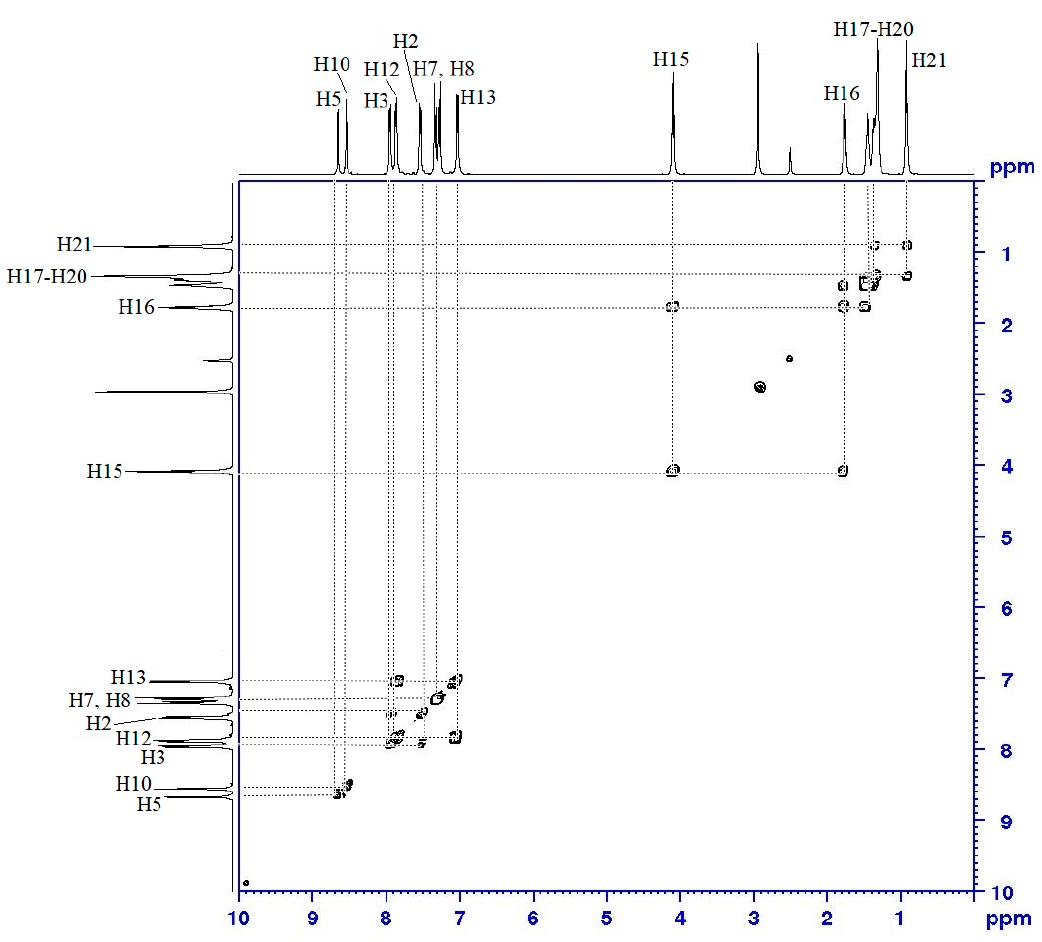
Figure 5. COSY ( 1 H– 1 H) spectrum of compound 4a .